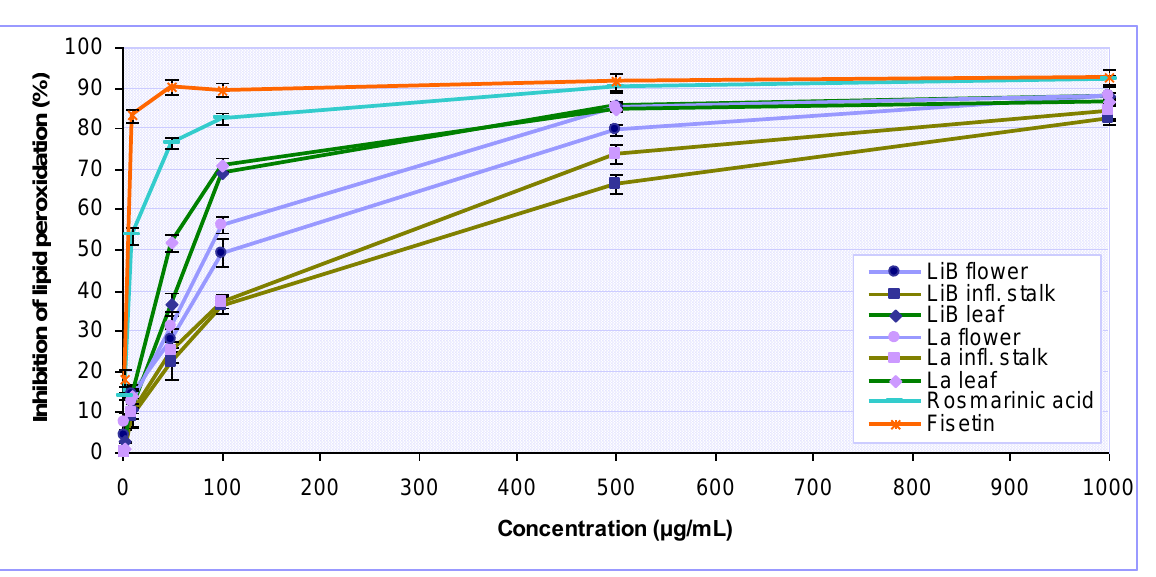
Figure 5. Inhibition of lipid peroxidation by various Lavandula x intermedia 'Budrovka' (LiB) and L. angustifolia (La) extracts as well as rosmarinic acid at different concentrations. Fisetin was used as reference.